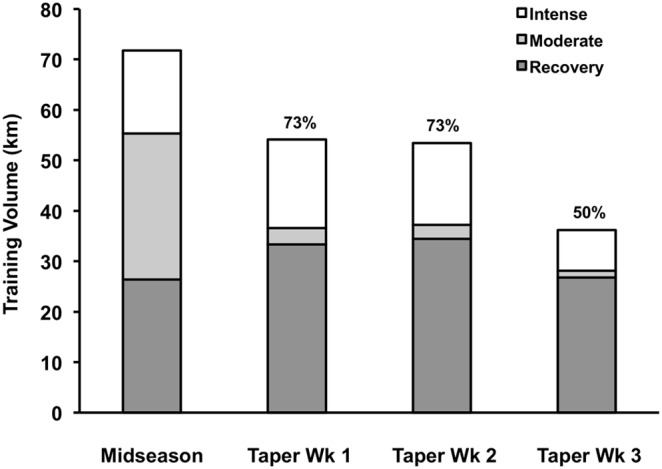
Summary of training volume and intensity during heavy training (11 wks) and each week of taper (3 wks), reproduced from Luden et al. [2] with permission from the American Physiological Society.